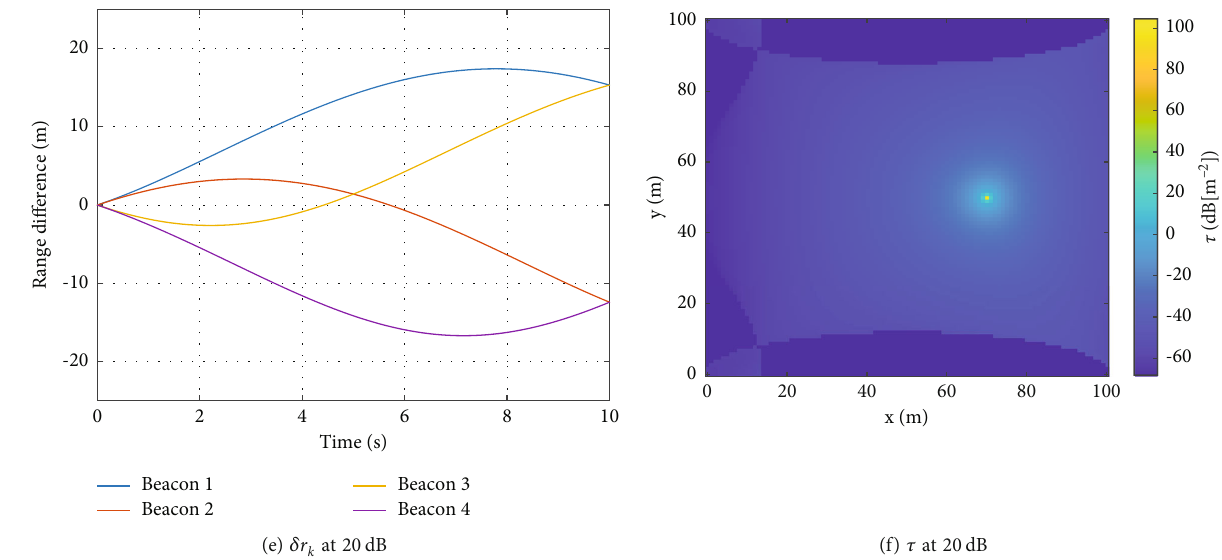
Figure 8: Range di ff erence δ r